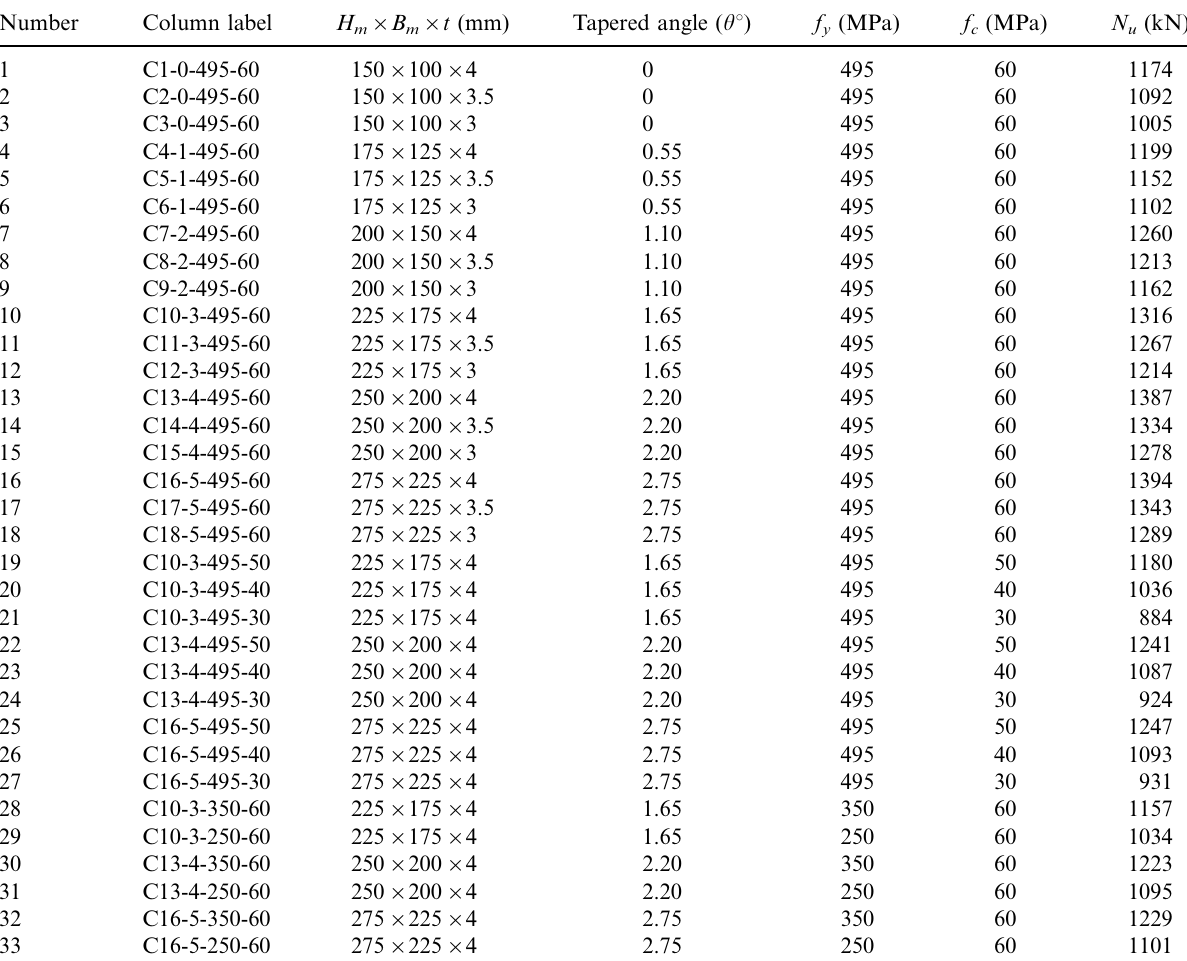
Table 1. Specifications and ultimate axial load capacities ( N u ) of the